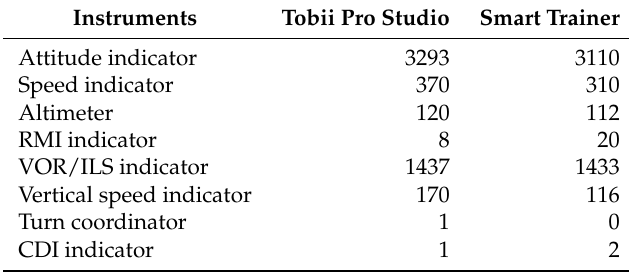
Table 2. The number of fixations registered with Tobii Pro Studio and the Smart